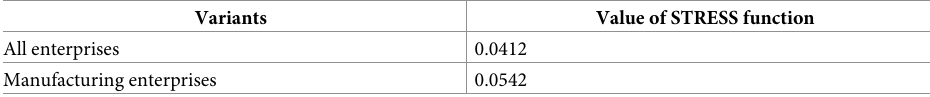
Table 11. The value of STRESS